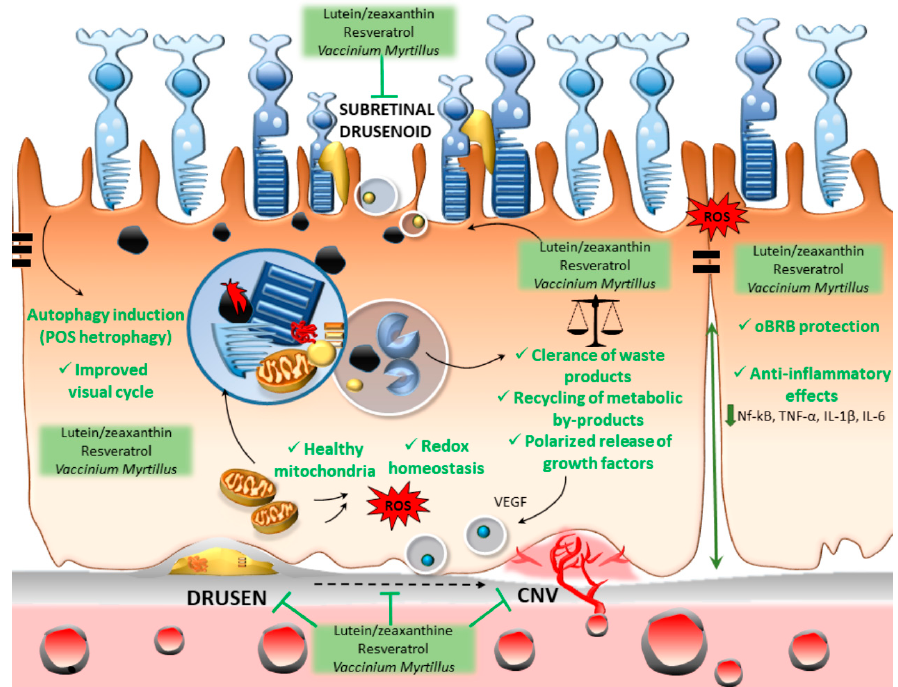
Figure 4. The effects of phytochemicals within the RPE . Lutein/zeaxanthin, resveratrol, and